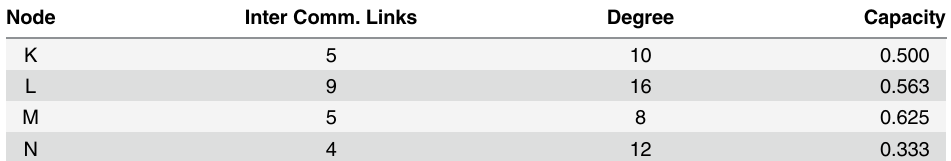
Table 1. Example of the capacity of a given node for accepting a neighbouring node into its